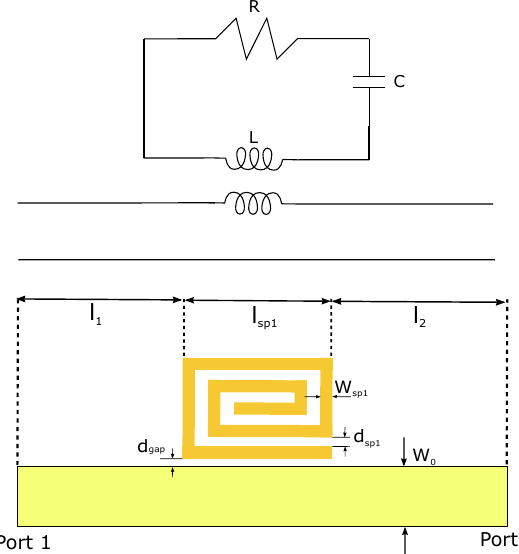
Figure 2. Layout of the spiral resonator and the equivalent shunt resonator